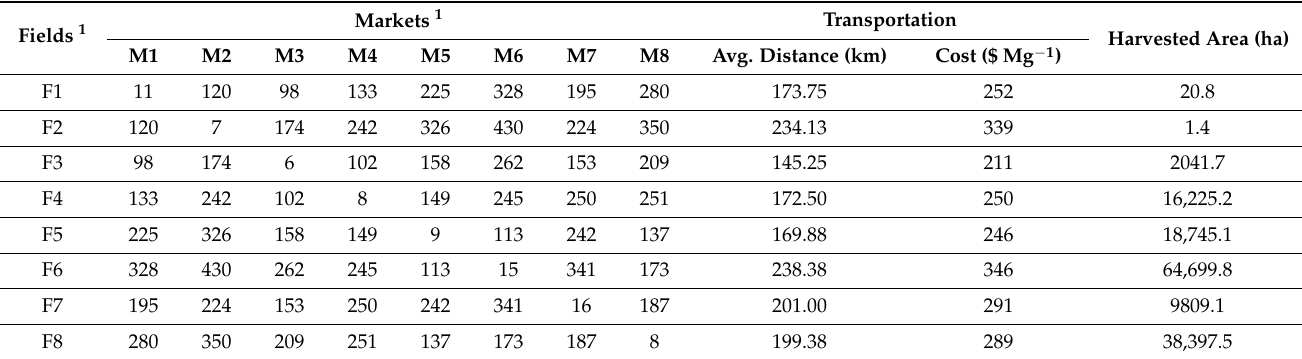
Table 8. Distance matrix between rice paddy fields and markets.